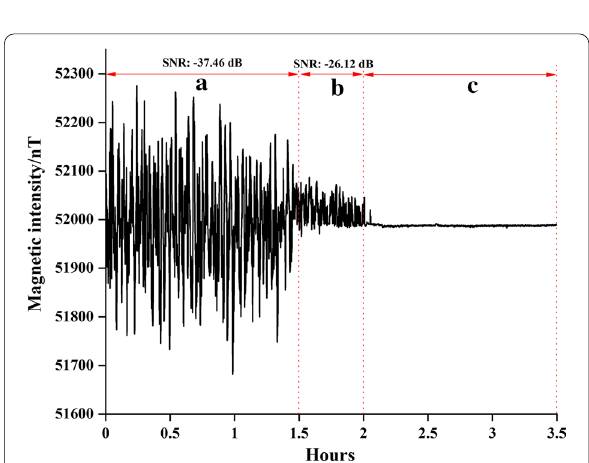
Fig. 3 Magnetic data collected at different metro operation states. a Two-track operation. b One-track operation. c Powered